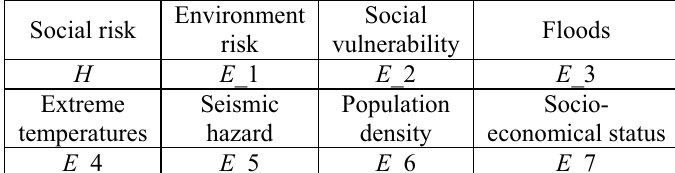
Table 3. Factors and conclusion in the social risk assessment